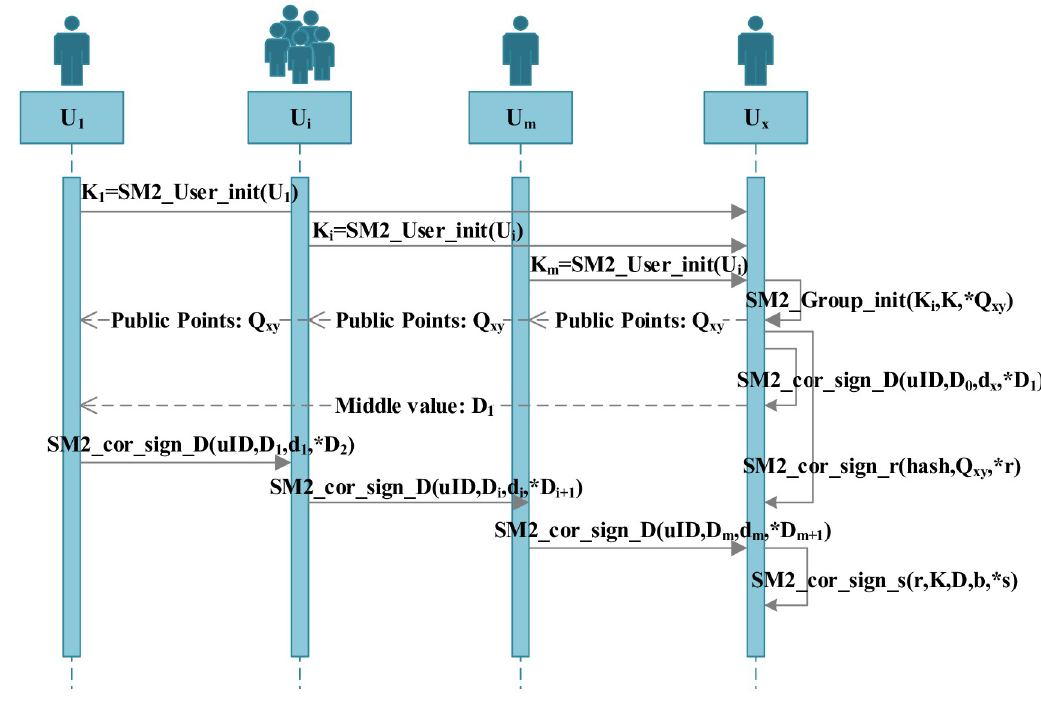
Fig 5. Co-signature timing